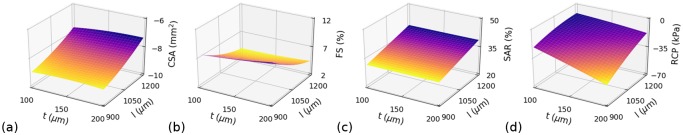
Response surfaces highlighting the combined influence of t and l on each performance metric (CSA, FS, SAR and RCP), holding Ar and w constant at their baseline values (Ar = 1.35 and w = 150 μm).